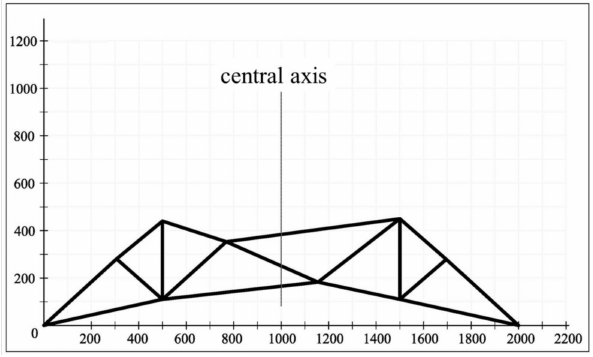
Figure 4. Picture of a truss sample.